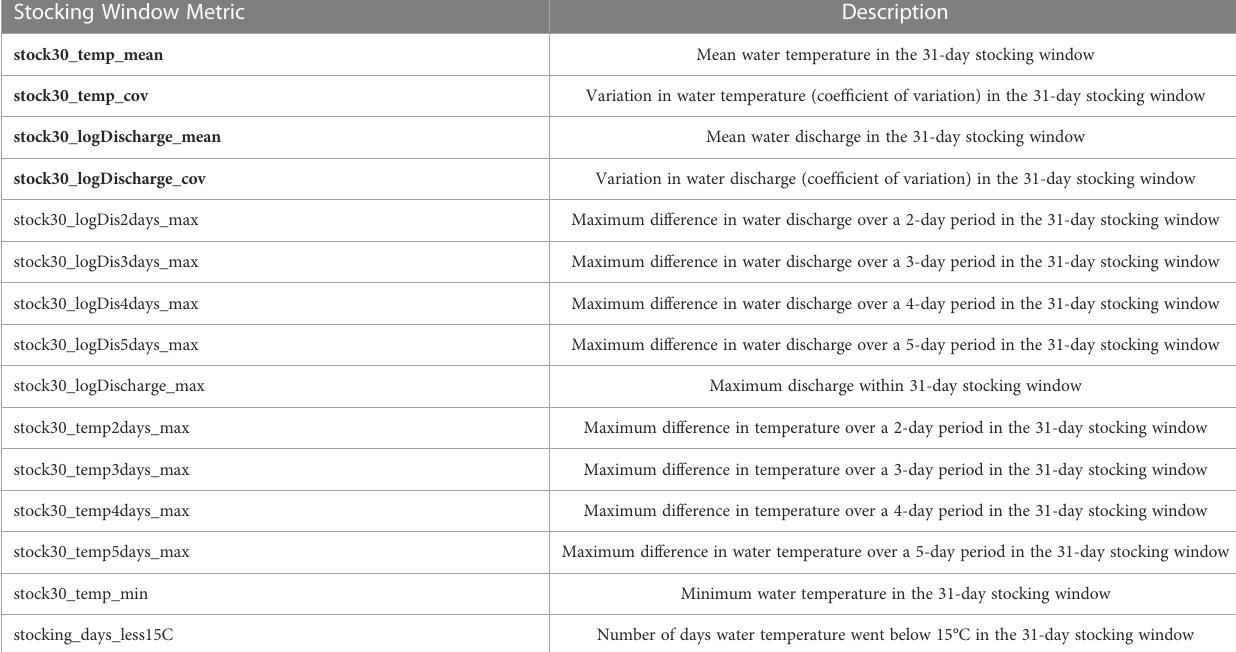
TABLE 2 Temperature and river fl ow covariates used to predict survival of Murray cod fi ngerlings in the lower Mitta Mitta River. Stocking Window